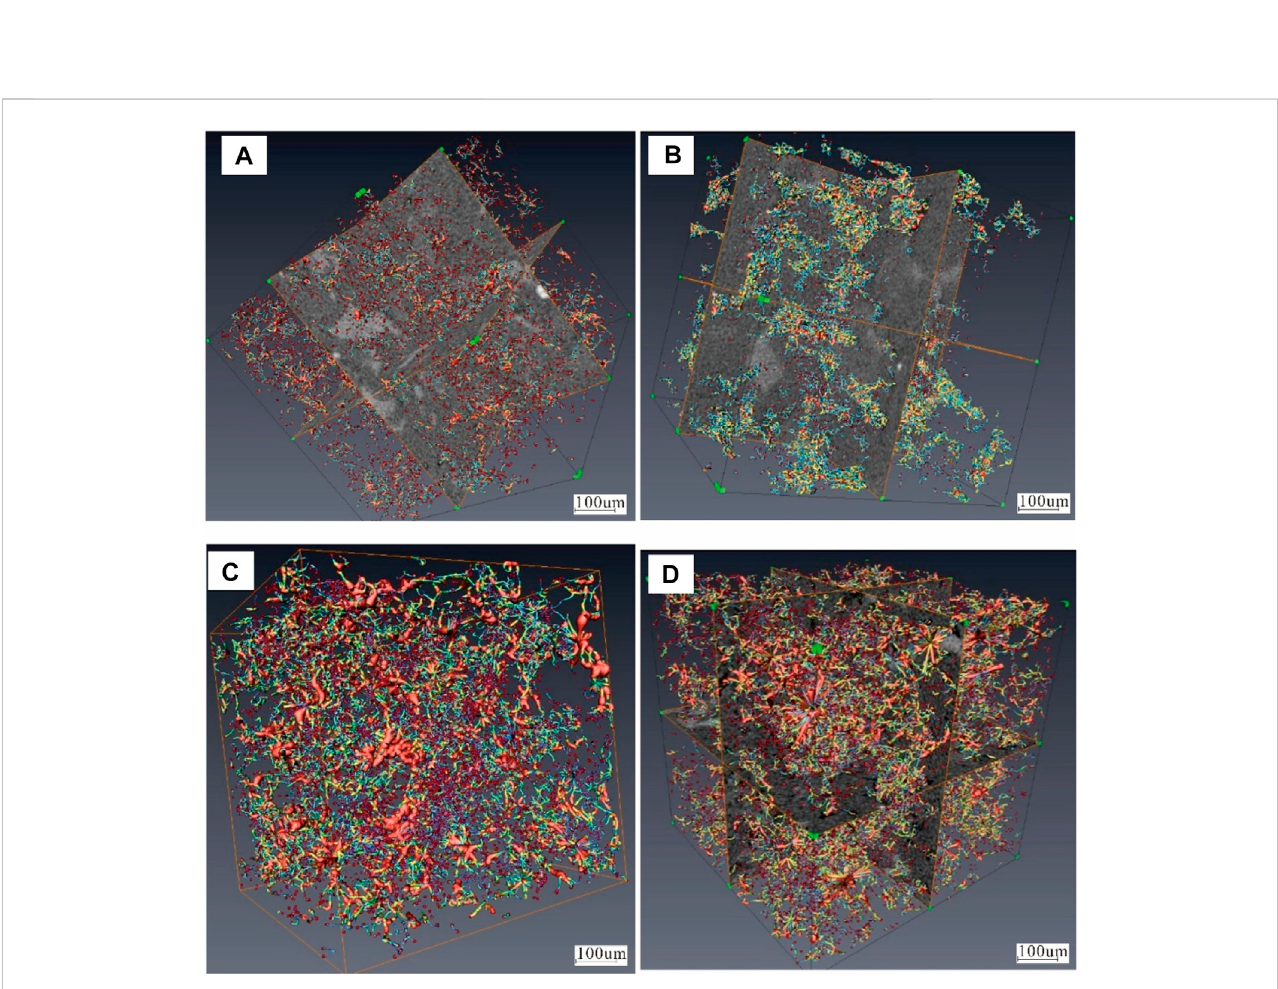
FIGURE 9 Three-dimensional pore – throat structures of the Gaotaizi oil layer based on three-dimensional CT scanning; (A) Jin 341 well, dry layer, carbonate cementation, porosity of 2.6%; (B) Jin 341 well, oil immersion, porosity of 5.8%, good pore connectivity; (C) Jin 191 well, oil immersion, porosity of 7.9%, well developed pores and good connectivity; (D) Jin 45 well, dry layer, porosity of 8.1%, extremely well-developed pores and good connectivity, coordination number of 13.4.